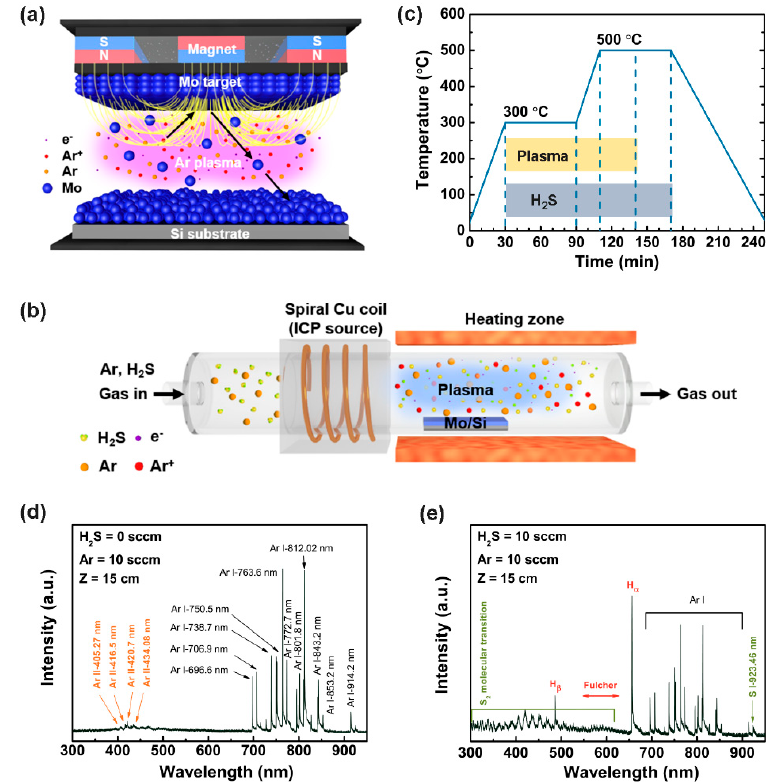
Figure 1. Schematics of the experimental setup for the two-step synthesis of MoS 2 : ( a ) schematic of the radiofrequency (RF) magnetron sputtering system for Mo deposition on a p-type Si substrate; ( b ) schematic of the inductively coupled plasma (ICP)-assisted plasma-enhanced chemical vapor deposition (PECVD) method for sulfurizing the Mo film to obtain MoS 2 . ( c ) Temperature profile with plasma and H 2 S gas flow during the PECVD growth process. ( d ) Typical optical emission spectroscopy (OES) spectrum of pure Ar plasma at a power of 300 W. ( e ) OES spectrum of Ar and H 2 S plasma at a power of 300 W.